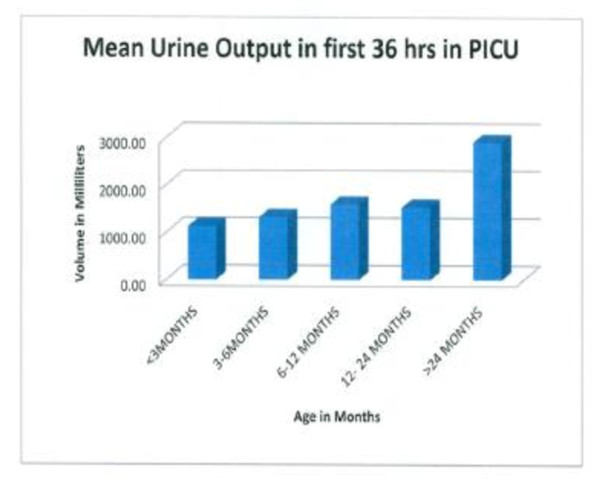
Urine output was a surrogate marker for intravascular volume status; increased urine output correlates with crystalloid administration (P < 0.001).